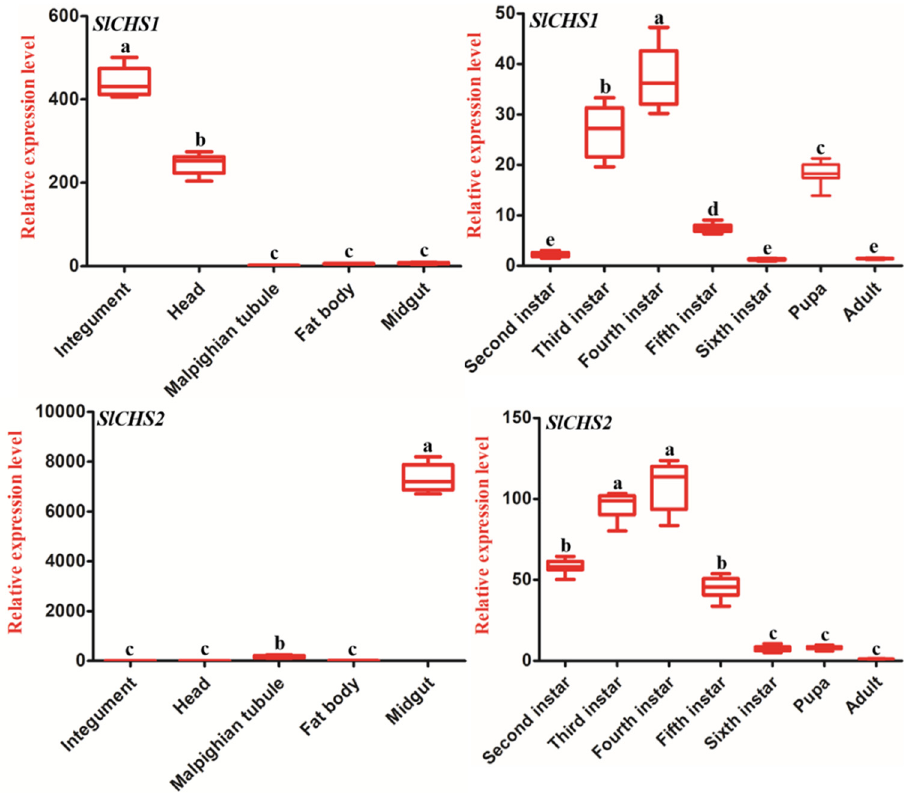
Figure 3. Expression patterns of SlCHS1 and SlCHS2 in different tissues of sixth-instar larvae and at different developmental stages of the larvae of S. litura . Relative mRNA levels of SlCHS1 and SlCHS2 as examined using RT-qPCR. Data were normalized using glyceraldehyde-3-phosphate dehydrogenase ( GAPDH ) and are represented as the means ± standard errors of the means from three independent experiments. Relative expression levels were calculated using the 2 - ∆∆ Ct method. Statistical analysis was performed using SPSS software. All data were analyzed using ANOVA and Tukey’s test. The significant differences are indicated by a different letter, for example, a, b, and c ( p < 0.05). Insects 2020 , 11 , x FOR PEER REVIEW